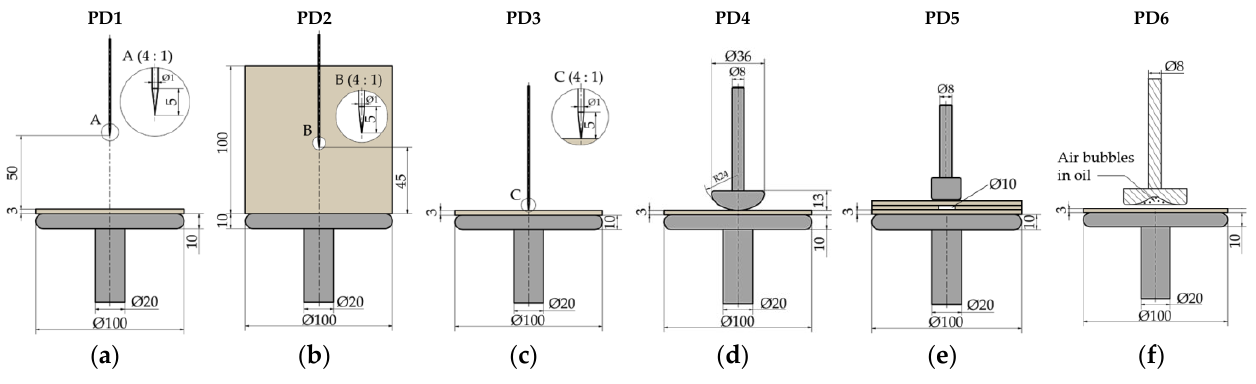
Figure 1. Schematic diagrams of electrode systems for generating PDs in oil–paper insulation: ( a ) PDs at needle tip. ( b ) Surface discharges on pressboard sample in oil with a negligibly small normal component of the electric field. ( c ) Creeping discharges (surface discharges on a pressboard sample in oil with significant normal component of electric field). ( d ) PDs in oil gap. ( e ) Void discharges. ( f ) PDs in air bubbles in mineral oil.